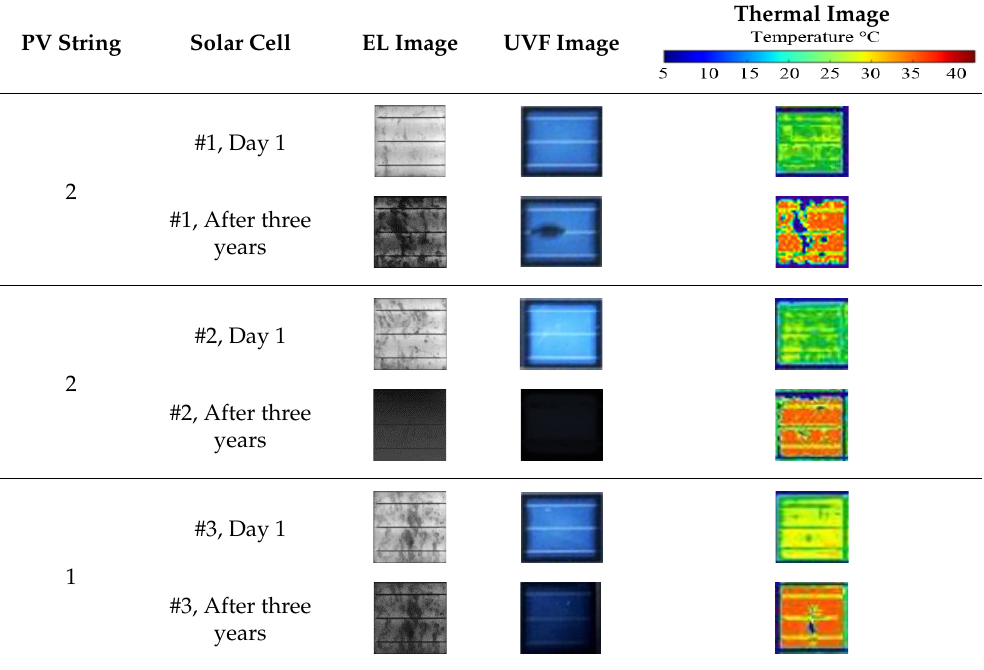
Table 3. Comparative examples of solar cell EL and UVF images.